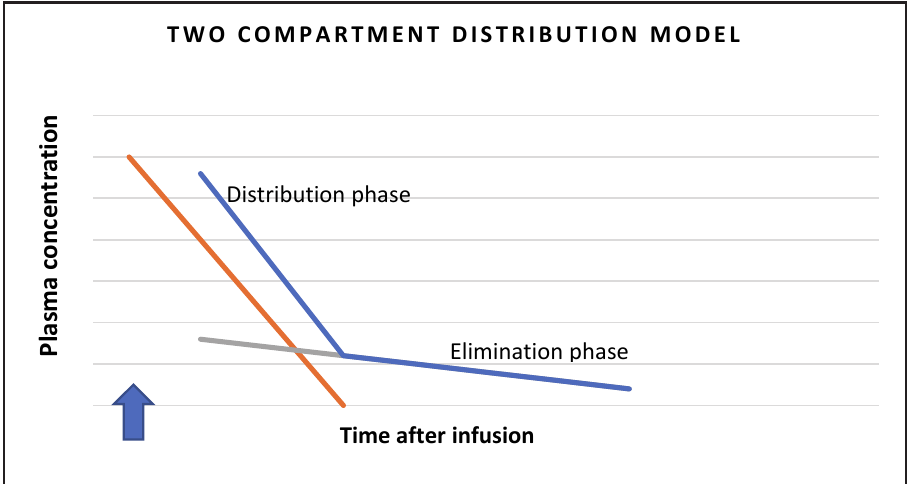
Figure 1. Two ‐ compartment distribution model schematic presentation. Figure 1. Two-compartment distribution model schematic